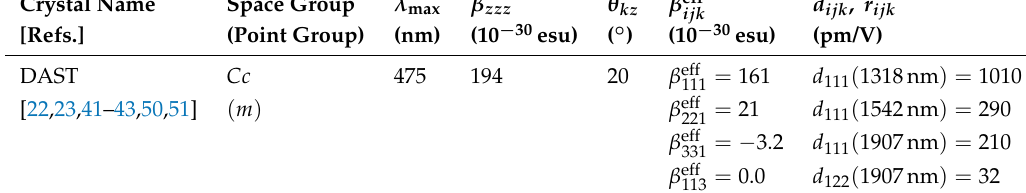
Table 1. Crystallographic symmetry, wavelength of absorption maximum λ max in methanol solution, main first hyperpolarizability component β zzz (non-resonant) calculated by quantum-chemical calculations, the angle θ kz between the main charge-transfer axis z of the chromophores and the polar axis k of the crystal, the non-zero elements of the effective first hyperpolarizability tensor β eff